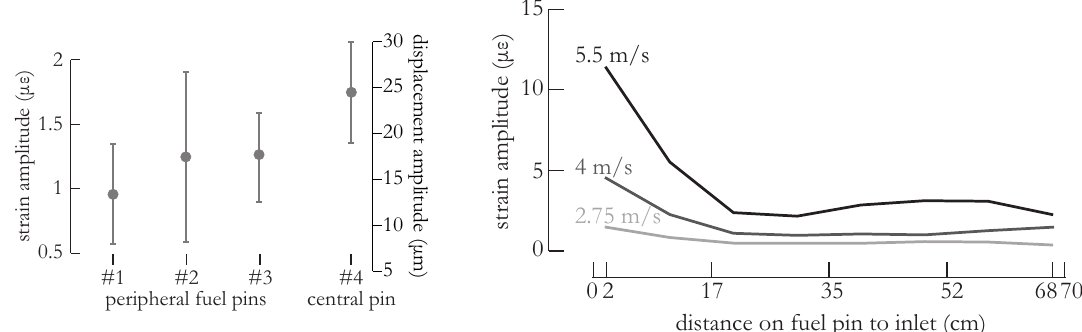
Figure 6. ( Left ): rms vibration amplitude and corresponding standard deviation averaged over all FBGs per fuel pin at an LBE flow of 4 m/s. The central fuel pin exhibits a slightly higher vibration amplitude compared to the peripheral fuel pins; ( Right ): The rms vibration amplitude measured with the different FBGs on the central fuel